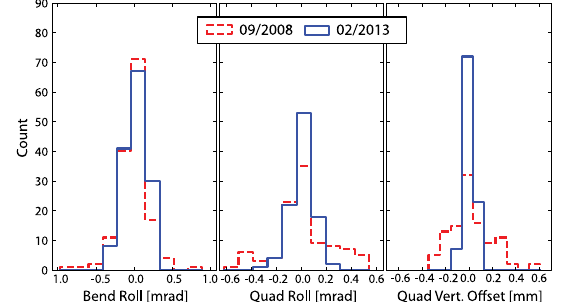
FIG. 1. Survey and alignment results for CesrTA as of December 2012 CesrTA run, compared to alignment in September 2008 at the start of the CesrTA program. Left to right: dipole roll, quadrupole tilt, and quadrupole vertical offset.